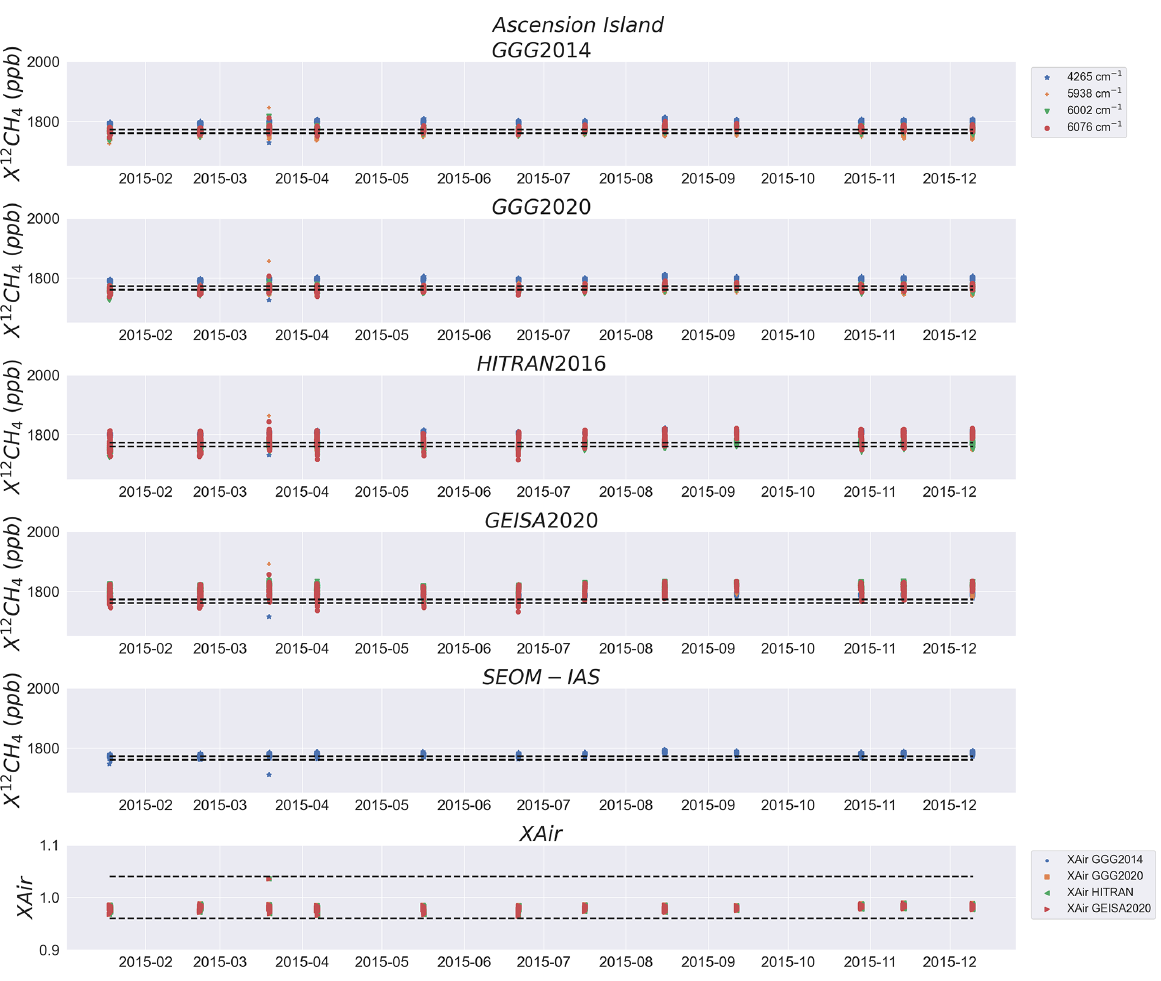
Figure 7. As Fig. 4 but for retrievals from the Ascension Island